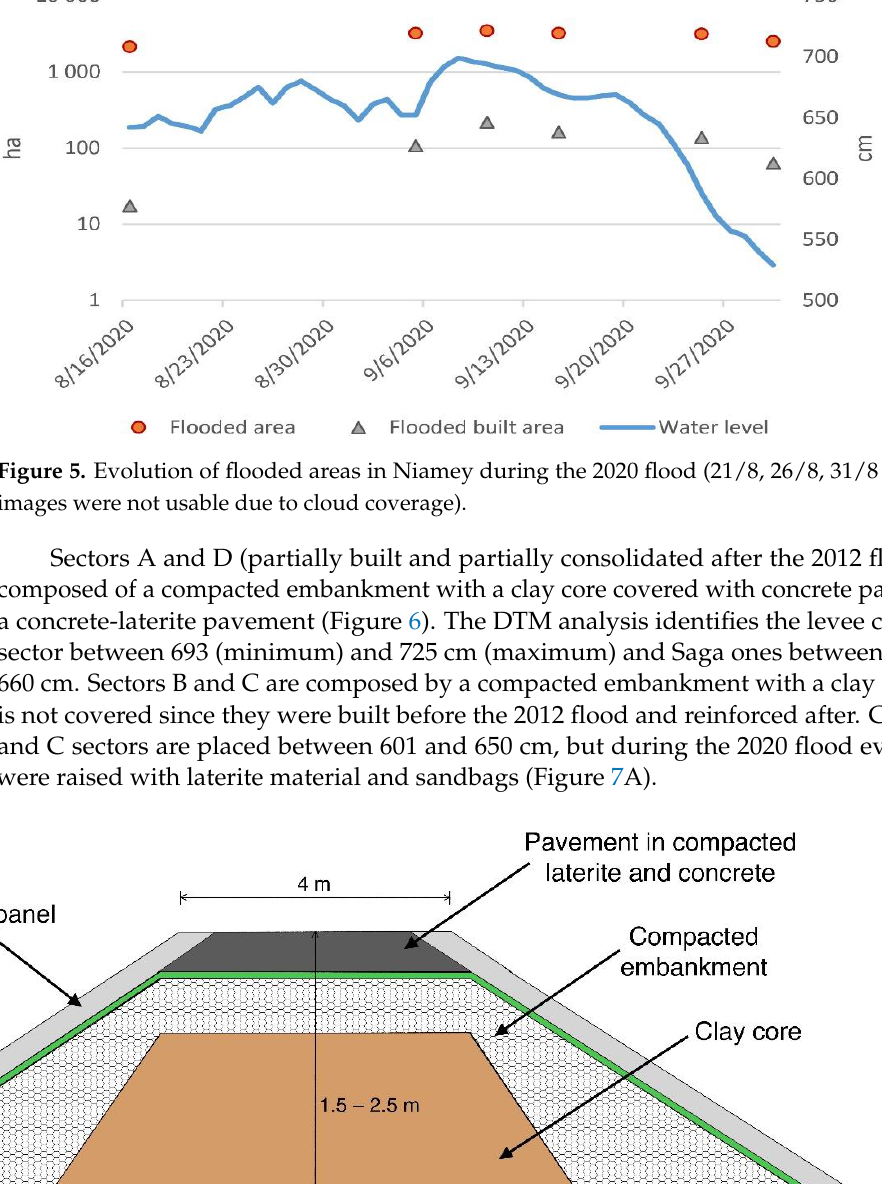
Figure 4. The Niger River in Niamey on 7 September 2020: The Lamordé levee and district on the right bank from the downstream aerial point of view (Author: Direction Générale de la Protection Civile du Niger).